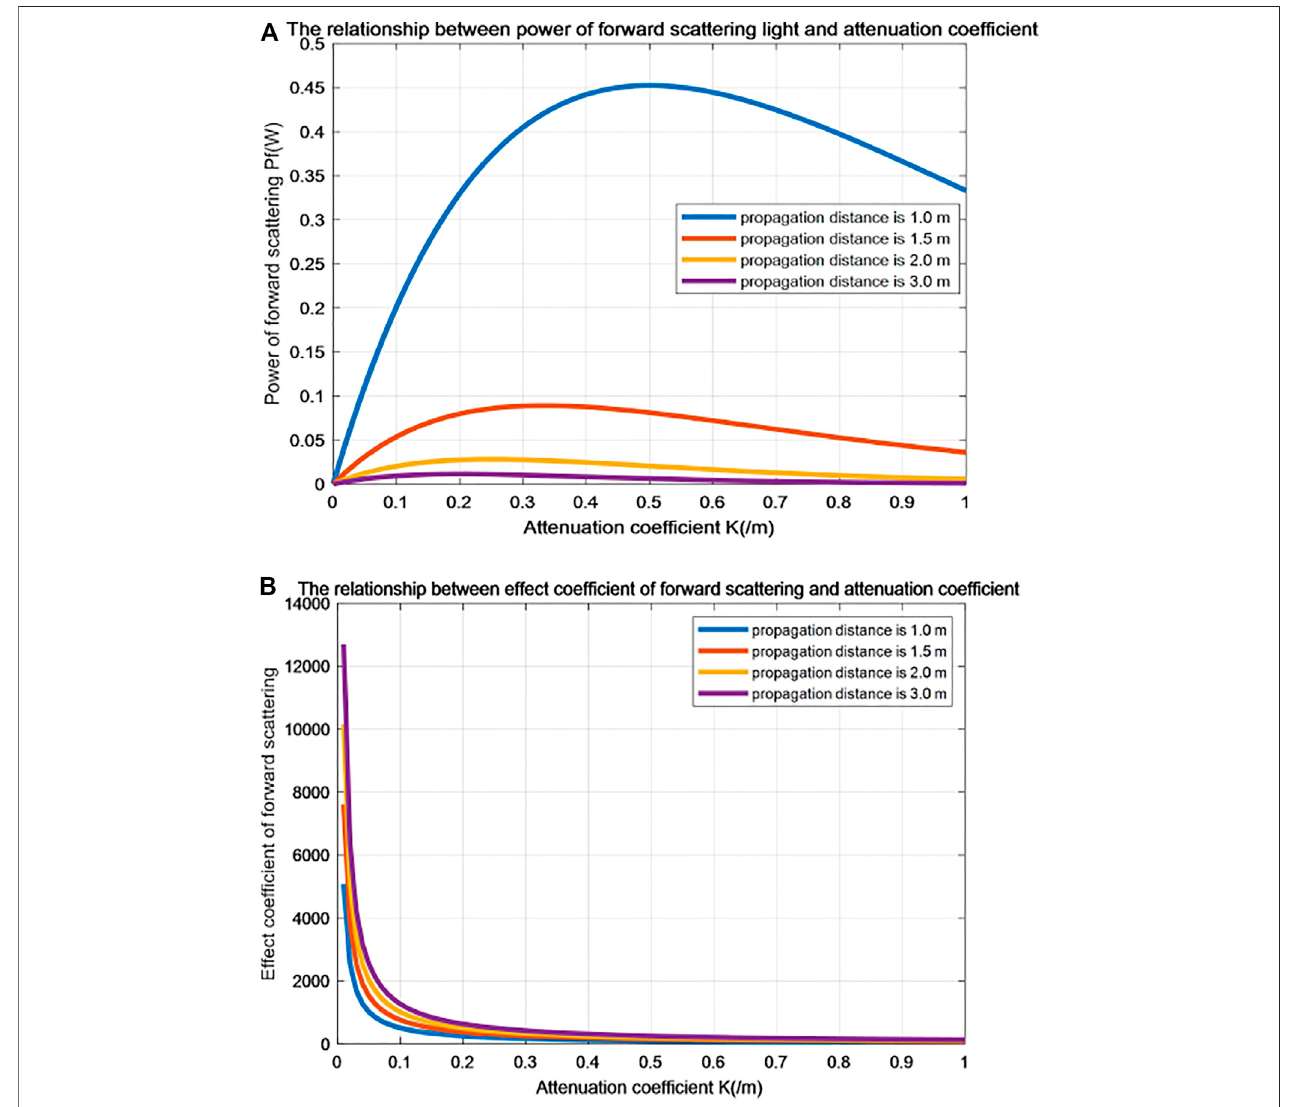
FIGURE5| Therelationshipbetweenforwardscatteringandattenuationcoef fi cient. (A) Therelationshipbetweenpowerofforwardscatteringlightandattenuation coef fi cient. (B) The relationship between effect coef fi cient of forward scarttering and attenuation coef fi cient.